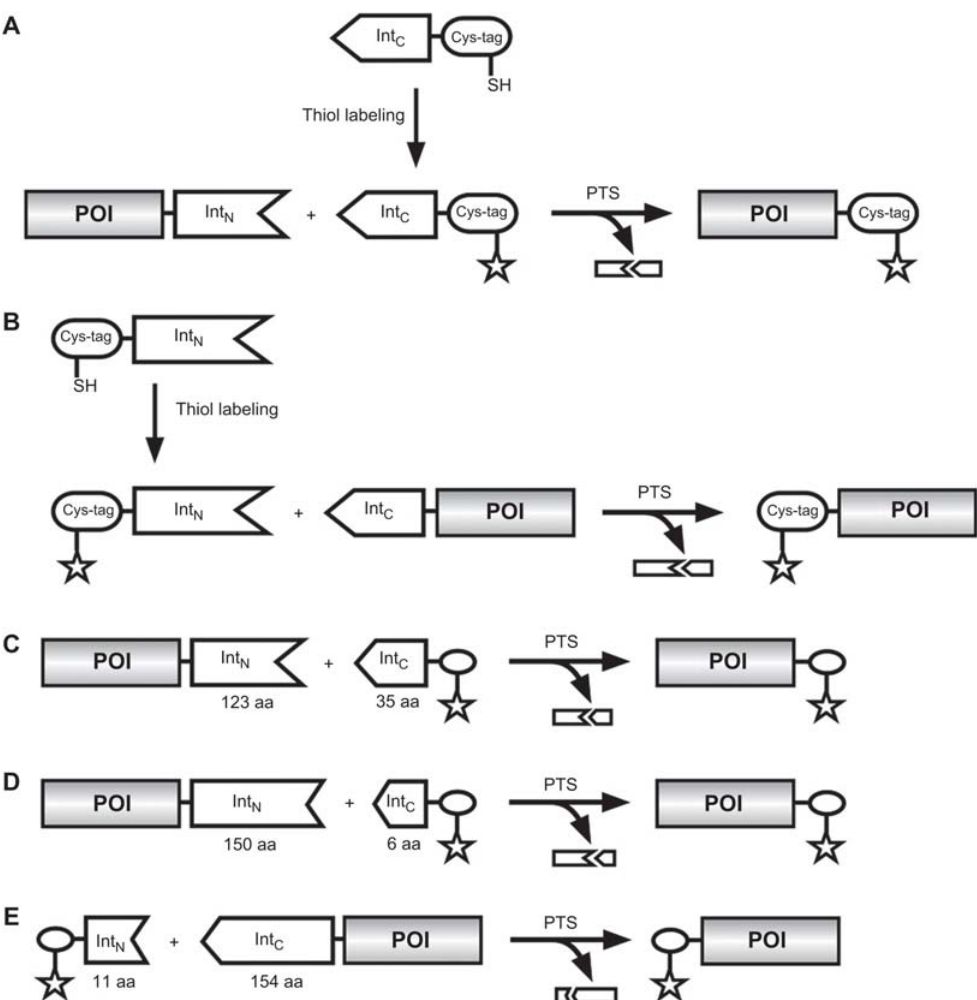
Figure 5 Current strategies for split intein-mediated site-specific protein modification. Labels/probes are indicated with a star. (A) The original Cys-tag approach designed for C-terminal modification. The Int /Cys-tag protein C is site-specifically modified on a single Cys residue located in the Cys-tag with a thiol-reactive probe. The split inteins used in the approach : 105 aa, Int : 48 aa) and Mxe GyrA (Int : 119 aa, Int : 79 aa). The protein of interest (POI) may were engineered from Ssp DnaB (Int N C N C contain free Cys residues or disulfide bonds (not shown). (B) Deviation of the Cys-tag approach for N-terminal modification. The intein used was the Psp -GBD Pol intein (Int : 440 aa, Int : 97 aa), in which a Cys351Ala mutation was introduced to ensure that thiol-labeling N C and Int are would only occur in the Cys-tag. (C) C-terminal modification catalyzed by the natural Ssp DnaE split intein (sizes of Int N C indicated). (D) C-terminal modification catalyzed by the engineered Ssp GyrB C6 split intein, which has a much smaller Int than the Ssp C DnaE intein (sizes of Int and Int are indicated). (E) N-terminal modification catalyzed by the engineered Ssp DnaB N11 split intein, N C (sizes of Int and Int are indicated). In C-E, the labels were incorporated into Int or Int during solid-phase which has a very short Int N N C C N peptide